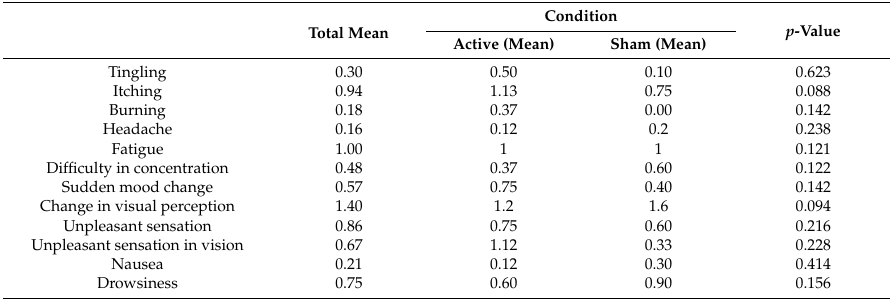
Table 4. Comparing the severity (out of 5) of side effects between active and sham groups for the DLPFC (dorsolateral prefrontal